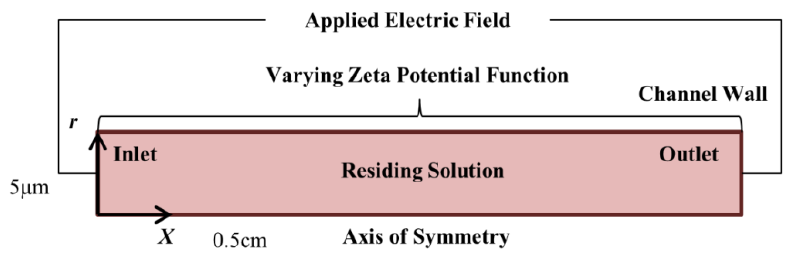
Figure 3. Domain for numerical simulation (not drawn to scale).